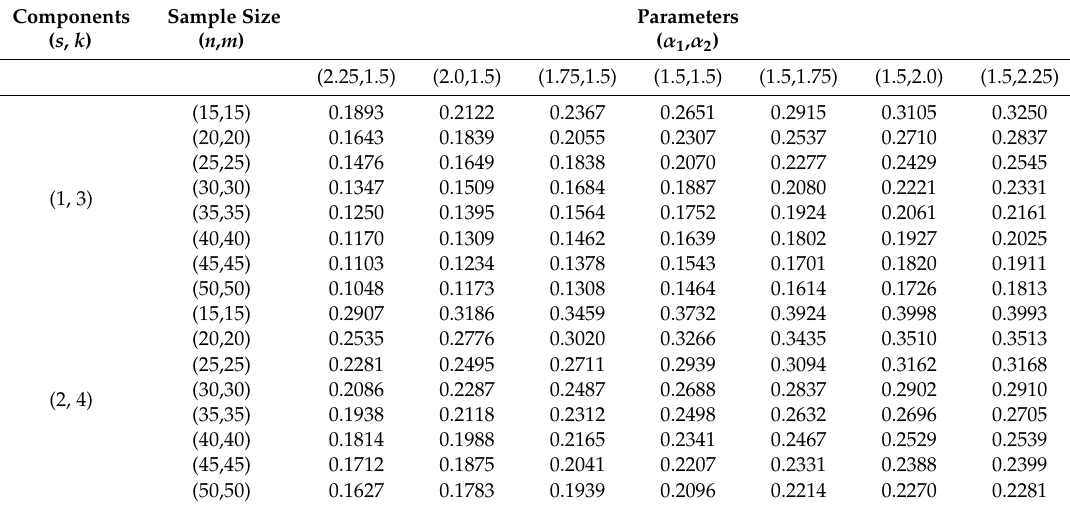
Table 3. Length of the 95% confidence interval of simulated reliability R s , k .